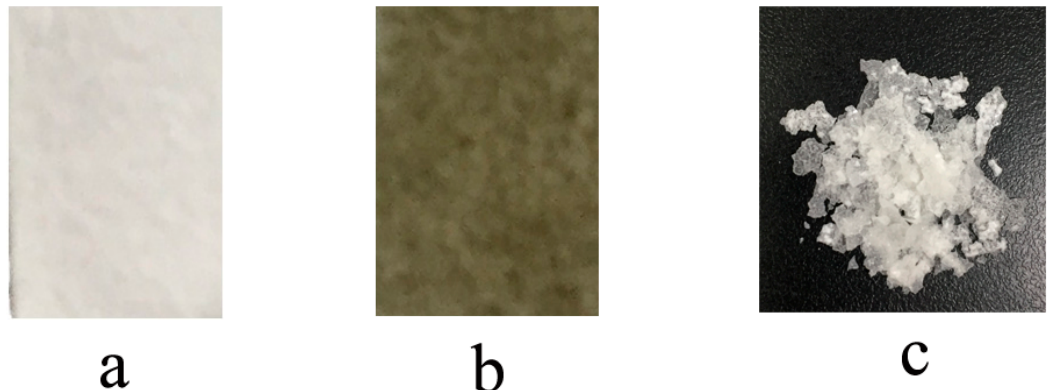
Figure 5. Photographs of ( a ) Cell-SH paper before used as reducing agent; ( b ) Cell-SH paper after used as reducing agent; and ( c ) final PMMA obtained from hetrogeneous AGET ATRP with Cell-SH as reducing agent in the present of a limited of air. Polymerization conditions: [MMA] 0 /[EBPA] 0 /[CuBr 2 ] 0 /[PMDETA] 0 = 400/1/0.25/0.5, m [Cell-SH] = 50 mg.